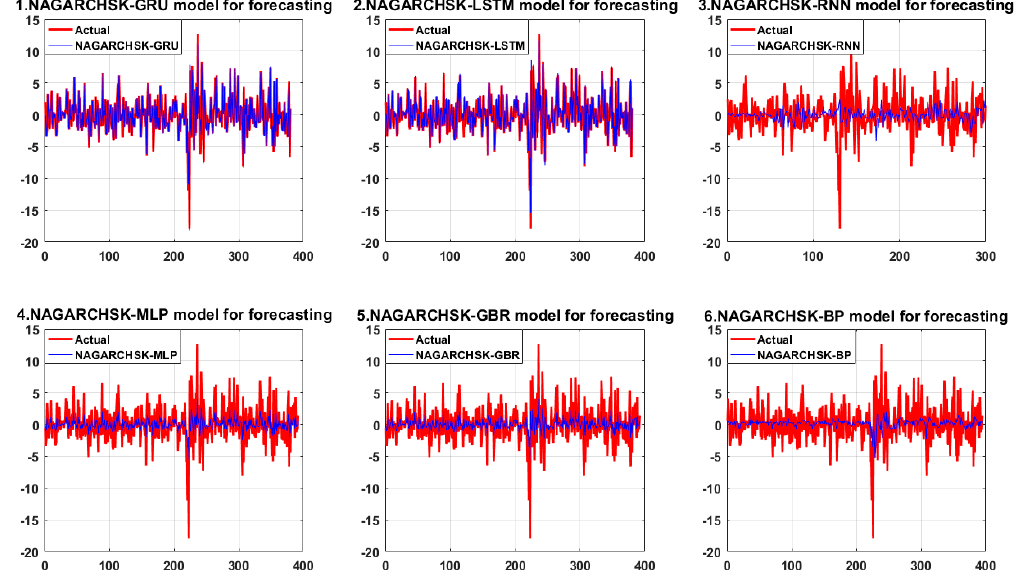
Figure 4. The forecasting performance of the proposed and benchmark model considering the features of time-varying conditional variance, conditional skewness and conditional kurtosis.